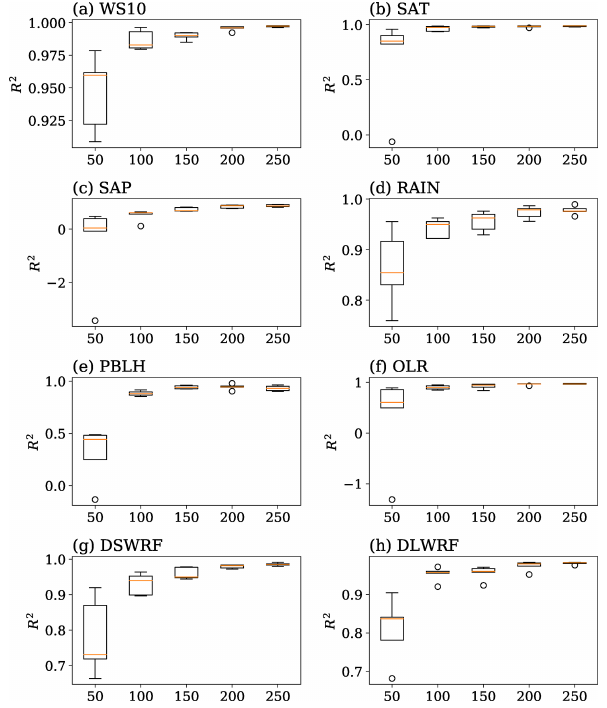
Figure 9. Cross-validation results of the GPR model with different sample sizes of 50, 100, 150, 200, and 250 for the meteorological variables